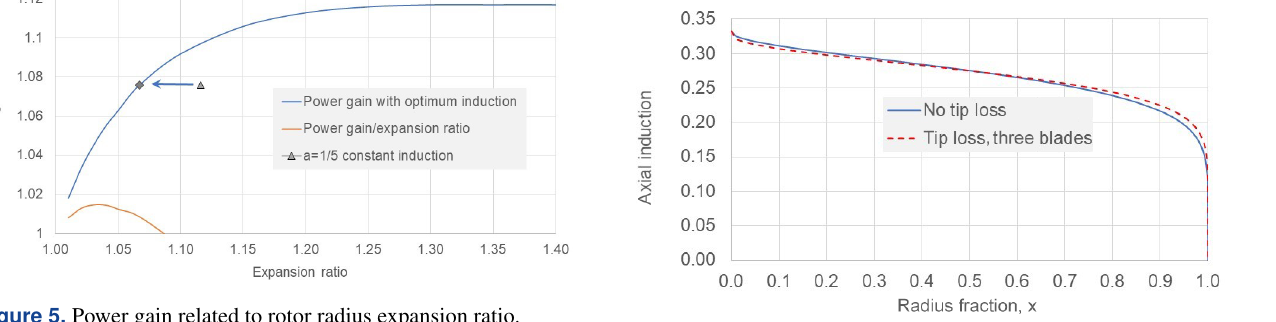
Figure 7. Effect of tip loss on optimum axial induction distributions for a power gain of